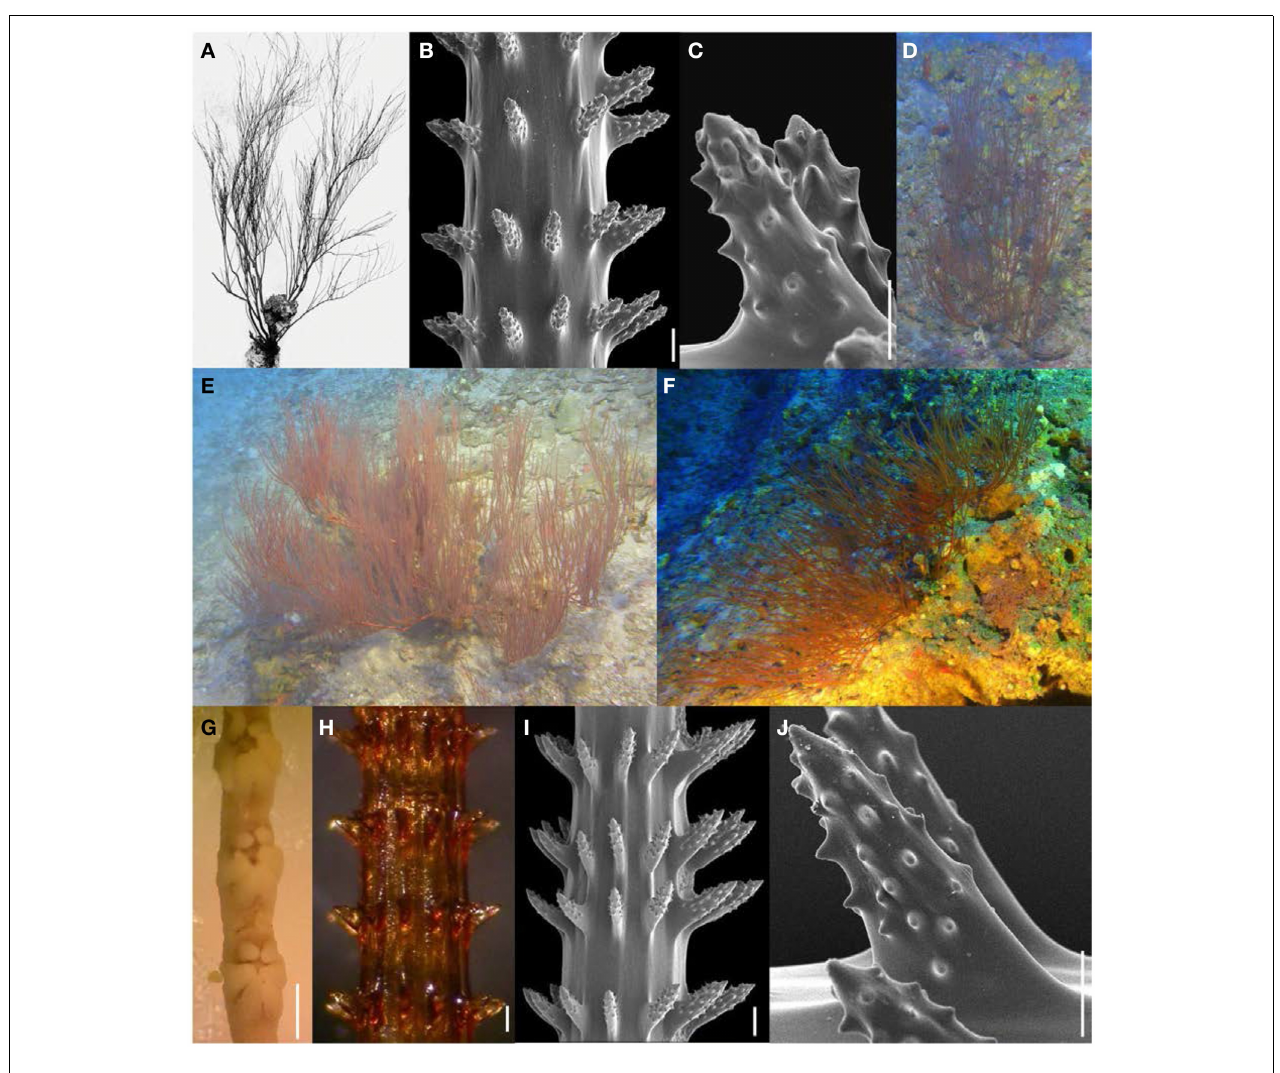
FIGURE 6 | (A–C) Aphanipathes verticillata verticillata holotype (MCZ 68) showing (A) . entire specimen, (B,C) skeletal spines under SEM (scale bars: (B) = 100; μ m; C = 50 μ m). (D–J) A. verticillata mauiensis specimens showing (D–F) colonies in situ , (G) preserved polyps on terminal branch